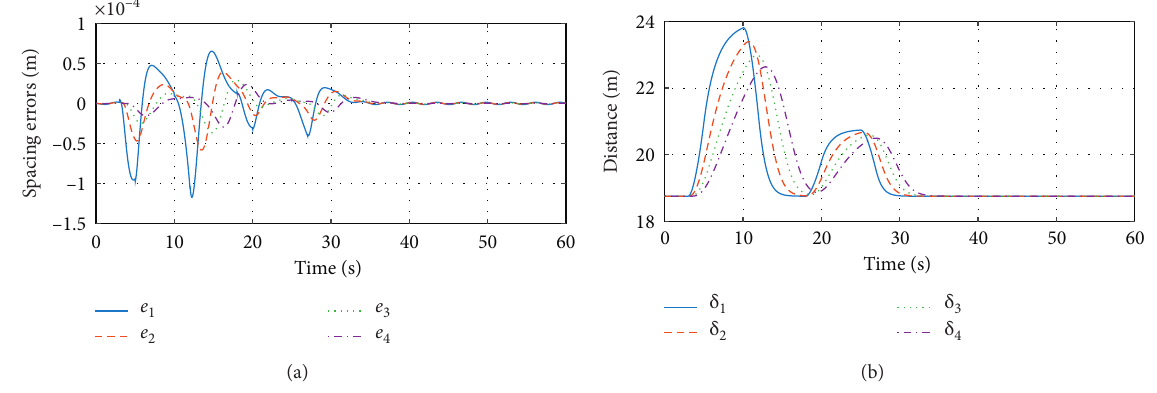
Figure 2: Spacing errors and distances of the